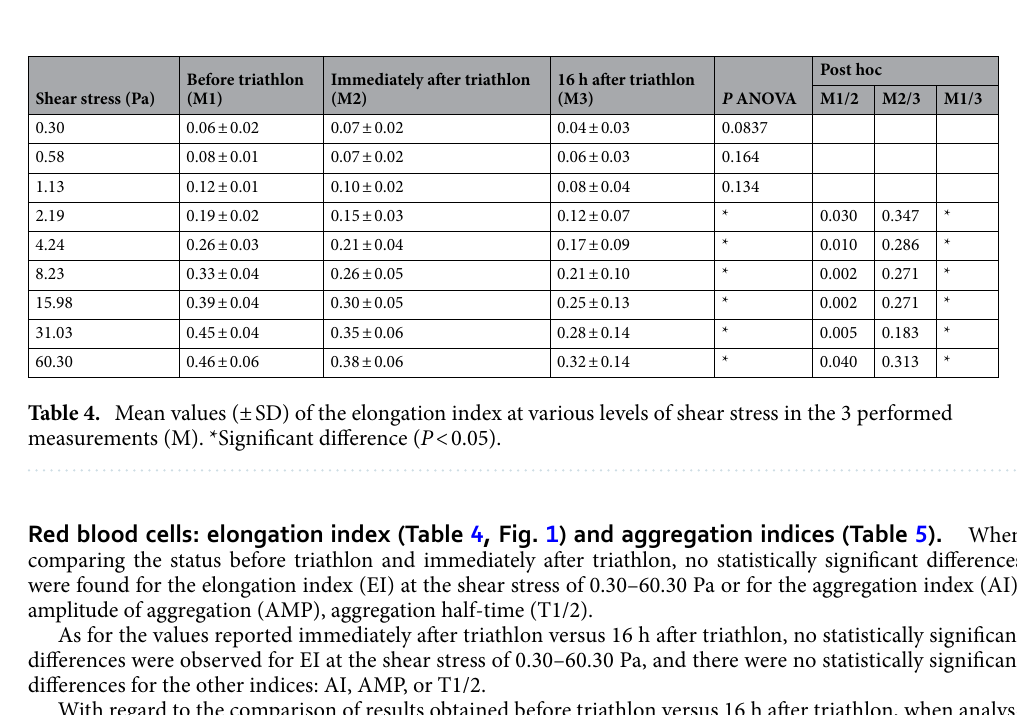
Shear stress (Pa)